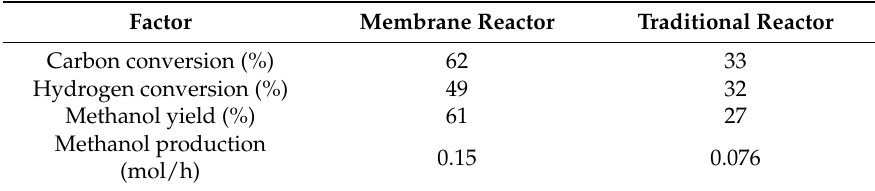
Table 5. Comparison between membrane reactor and traditional reactor for methanol